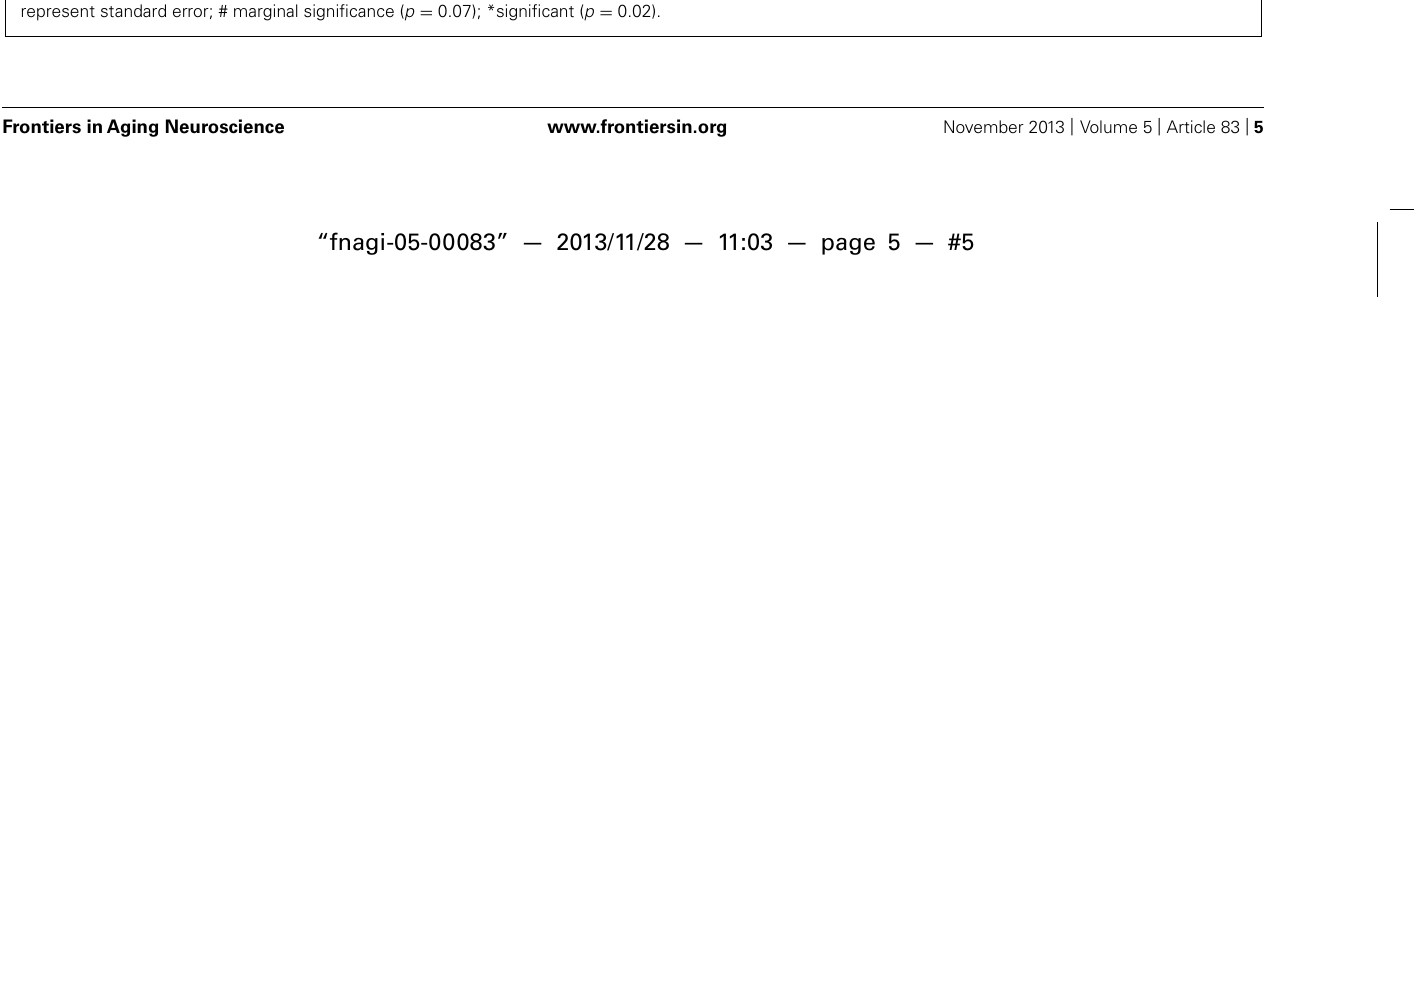
FIGURE 3 | Off-line change in skill learning (Skill 2 − Skill 1 adjusted to the RT at the end of session 1) for young (A) and older adults (B). Error bars represent standard error; # marginal significance ( p = 0.07); *significant ( p = 0.02).